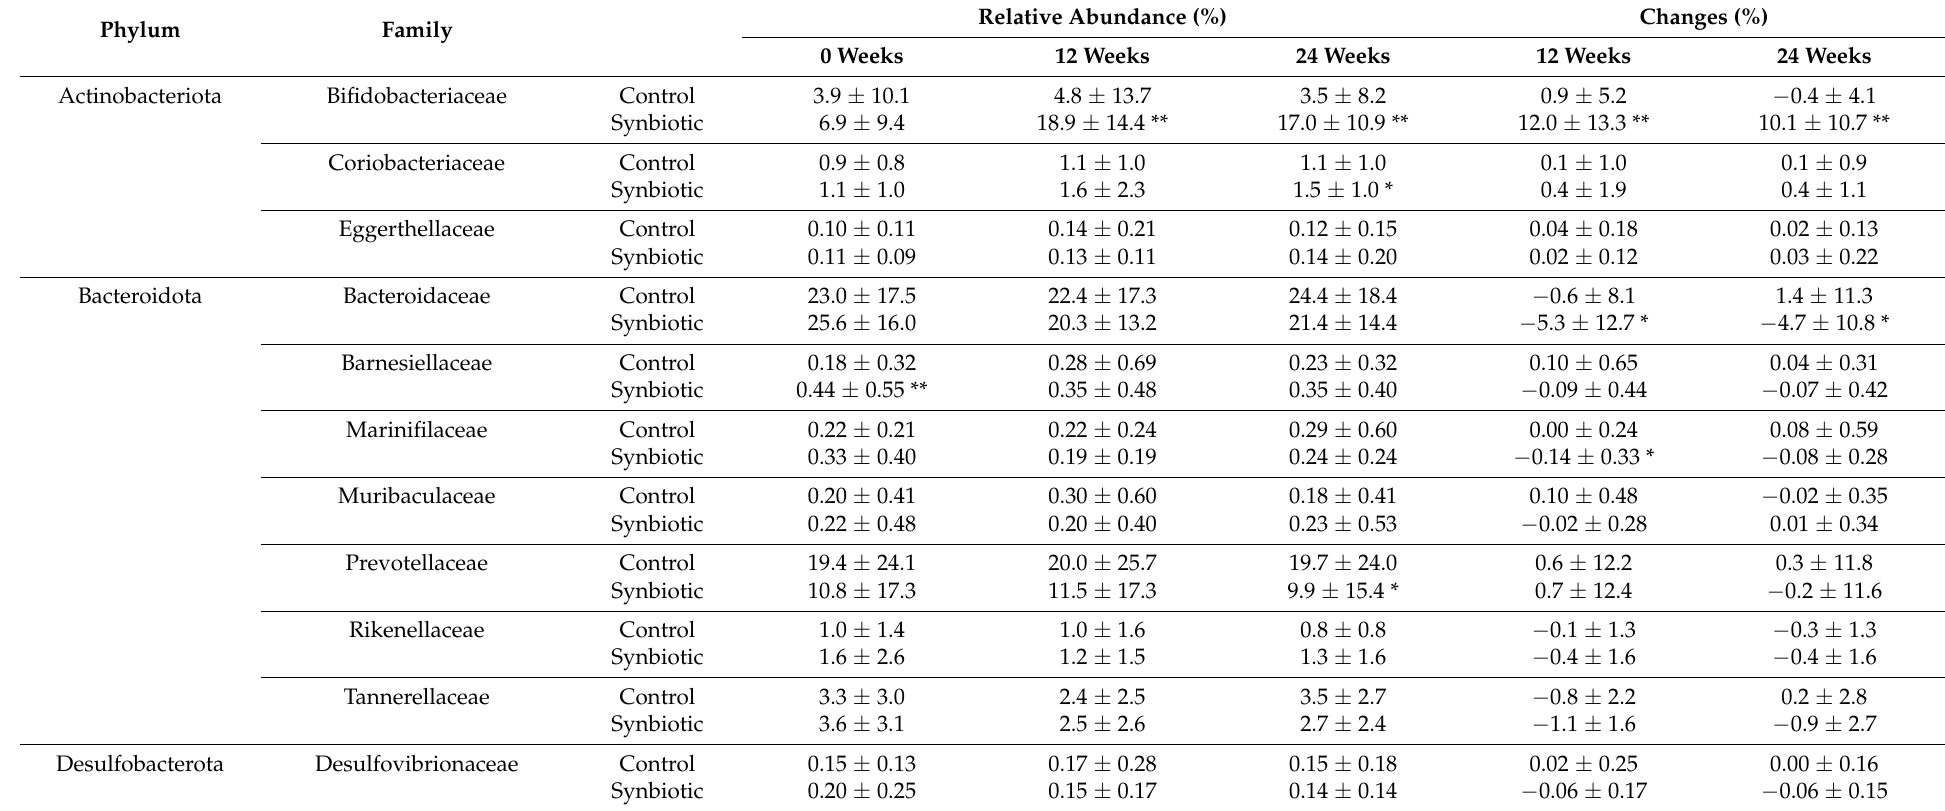
Table 6. Relative abundances at the family level and their changes as determined by 16S rRNA